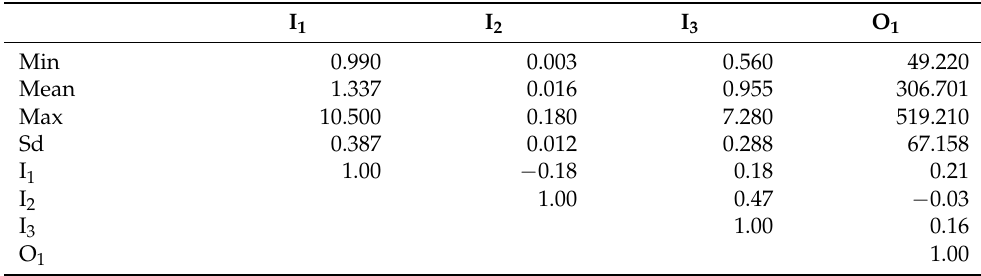
Table 1. Attributes of the dataset and correlation matrix for applied input and output